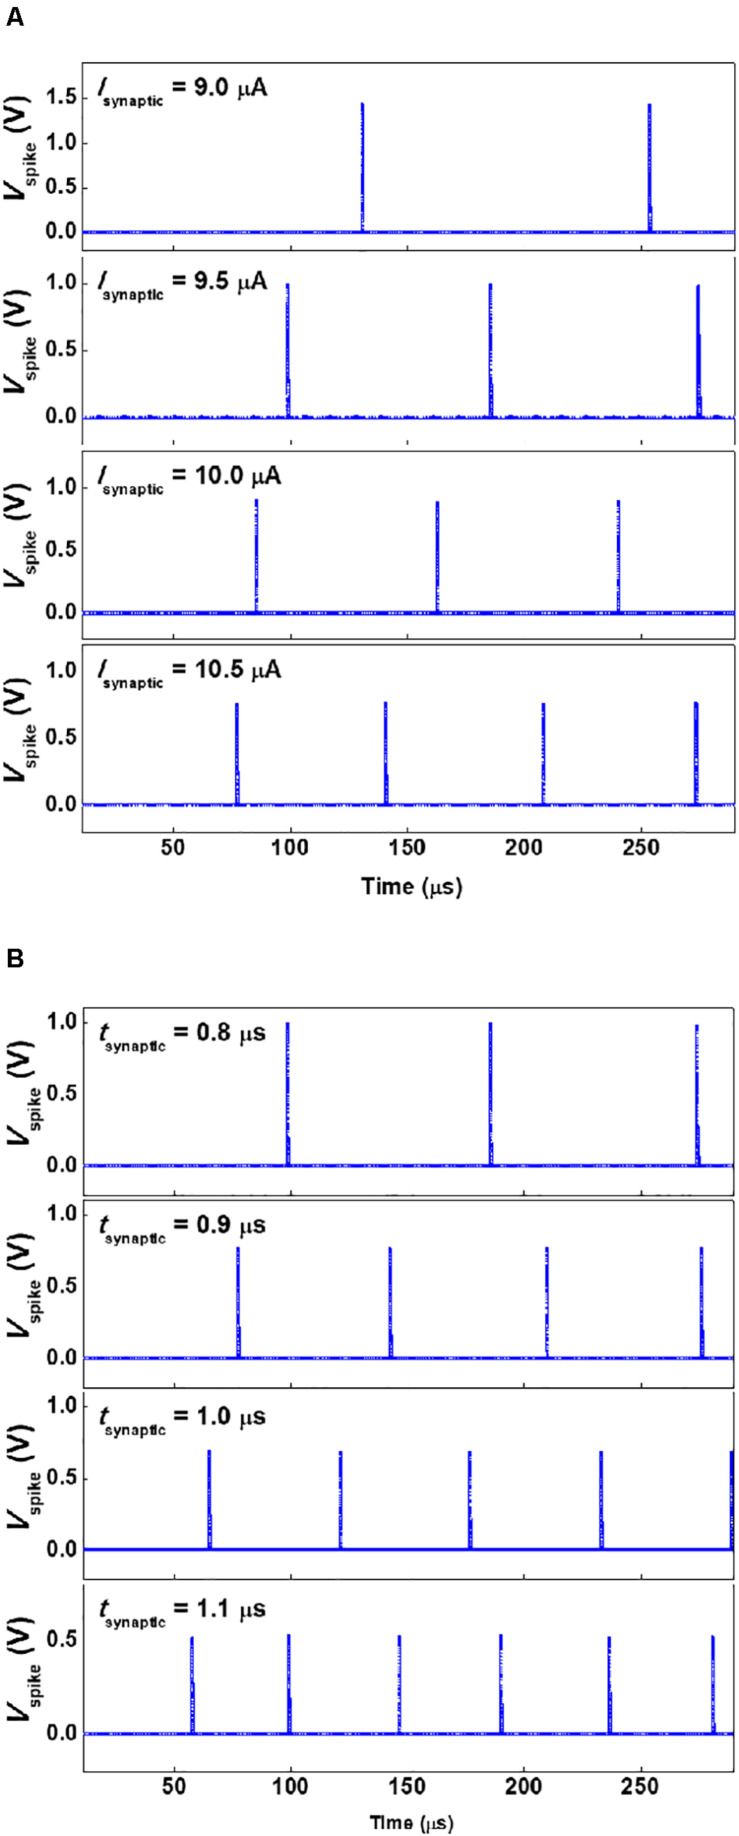
Firing frequency as a function of time for the (A)
ISynaptic amplitudes (with a time width (tSynaptic) of 0.8 μs and a period of 10 μs) from 9.0 to 10.5 μA by an increment of 0.5 μA, and (B)
ISynaptic time widths (with an amplitude of 9.5 μA and a period of 10 μs) from 0.8 to 1.1 μs by an increment of 0.1 μs.